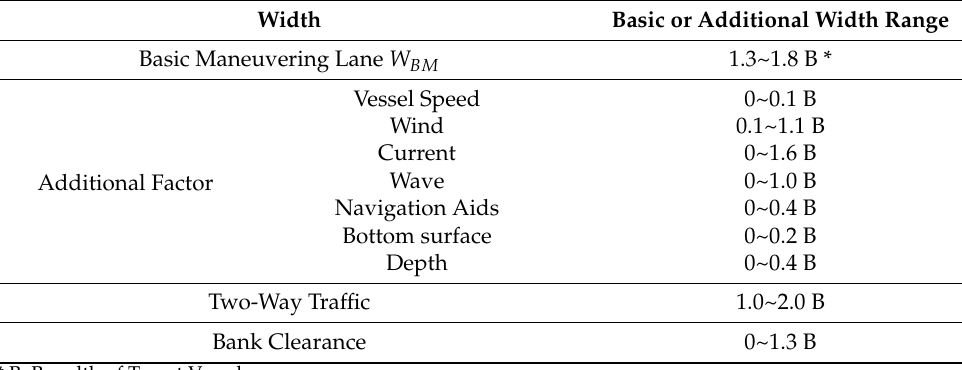
Table 2. Basic maneuvering lane and additional channel width of PIANC.